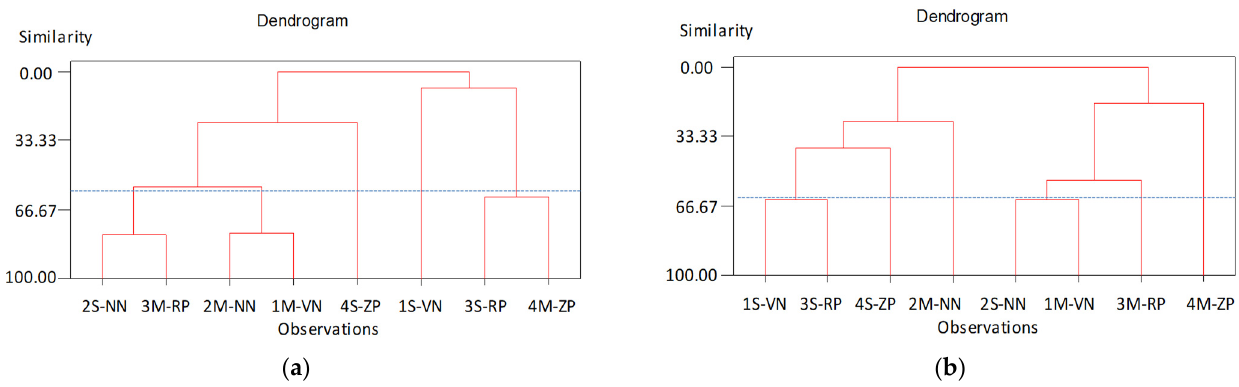
Figure 7. Agglomerative Hierarchical Clustering (AHC) dendrogram from ToF-SIMS positive ion spectra, on : ( a ) seeds integuments samples and ( b ) exocarps (fruit skins) samples.